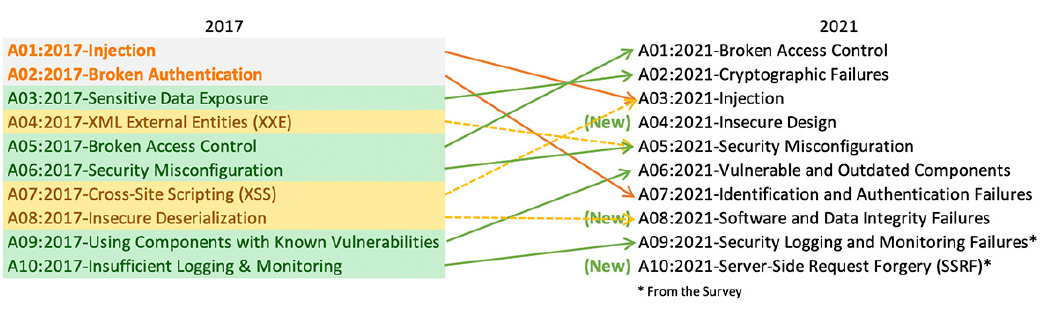
Figure 1. Updated OWASP Top 10 Vulnerabilities